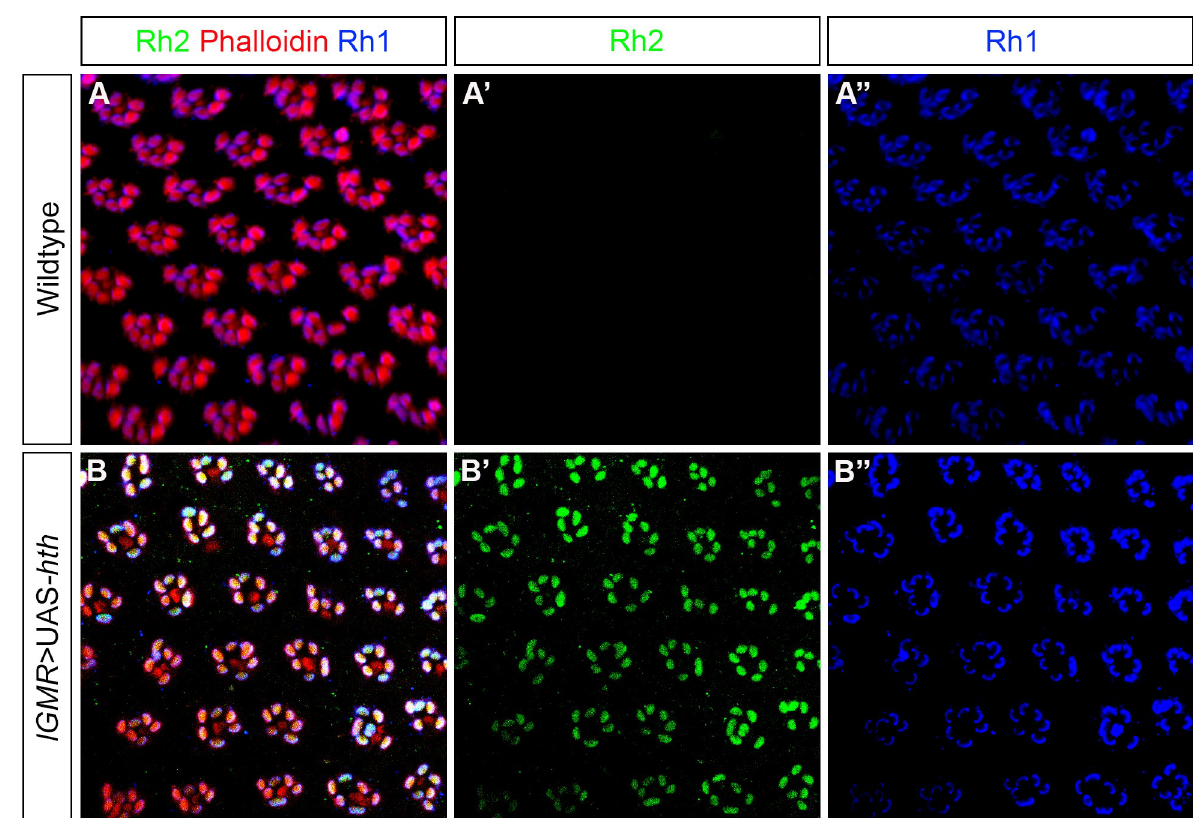
Fig 4. Hth misexpression phenotype in the retina. (A) Antibody staining to show expression of Rh2 and Rh1 in the wildtype retina. Rh2 (green) is normally not expressed in the retina (A’) whereas Rh1 (blue) is expressed in the outer PRs of retina (A”). PRs of the retina were stained with phalloidin (red). (B) Expression of Rh1 and Rh2 in the hth overexpression retina by lGMR -Gal4. Rh2 expression (green) can now be ectopically seen in the outer PRs of retina (B’) whereas Rh1 expression (blue) remained unaffected (B”).